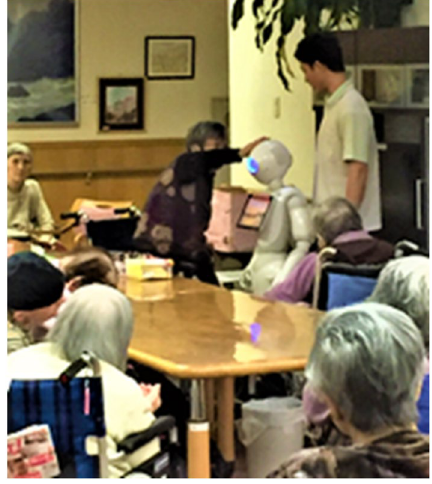
Fig. 5 Group gymnastics using the